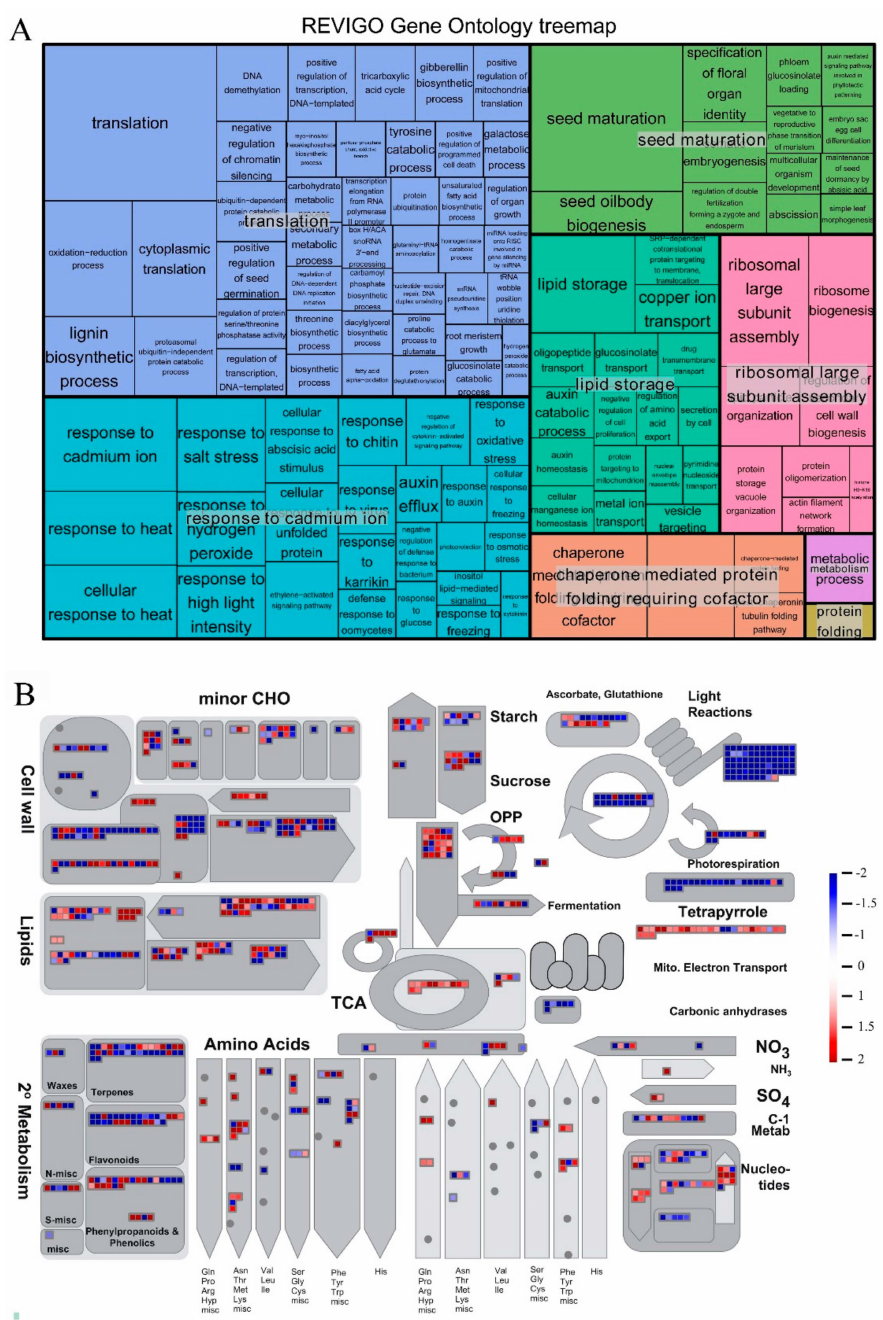
Figure 2. ( A ) REVIGO analysis for genes upregulated in U. pumila fruits. The representatives are classified into “superclusters” of loosely related terms, presented by di ff erent colors. The p value of the GO term is reflected by size of the rectangles which was calculated by TopGO. In this study, the biological processes enriched by upregulated genes were integrated into eight groups, 43 terms were summarized to the “translation” subset, 17 terms were classified to the “lipid storage” group, and 13 terms were assigned to the “seed maturation” group. ( B ) Di ff erently expressed genes (DEGs) viewed globally, which are involved in diverse metabolic pathways. DEGs were chosen for the metabolic pathway analysis using the MapMan software (3.5.1 R2). Di ff erent colors of boxes indicate the Log 2 of the expression ratio of DEGs genes. In total, 3055 and 2960 homologs were assigned in Arabidopsis for the dysregulated unigenes, respectively. In total, 1029 pathways were mapped for these genes by MapMan, of which, 117 pathways were filtered to be enriched by the dysregulated genes with the cuto ff p -value < 0.05 in ripe